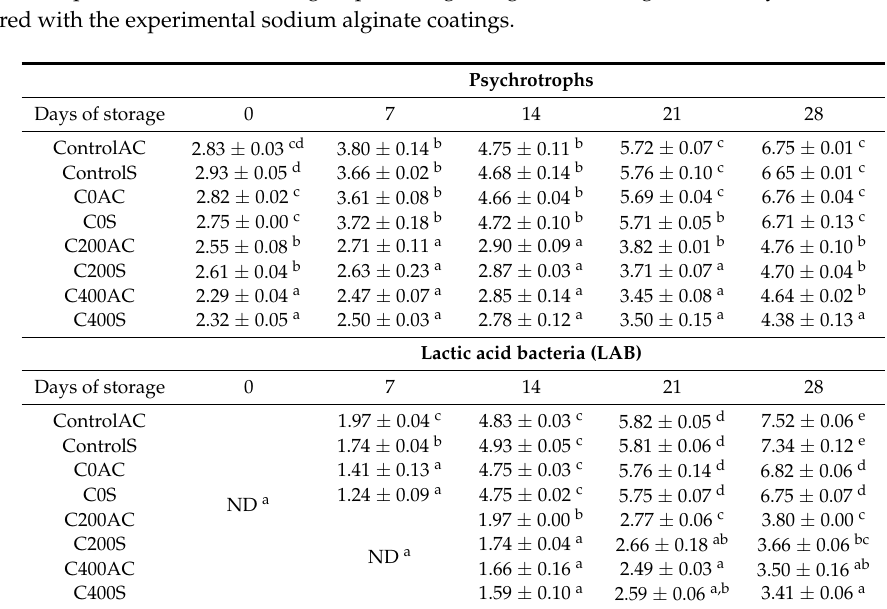
Table 4. Populations of microbial groups during refrigerated storage for 28 days of the sausages covered with the experimental sodium alginate